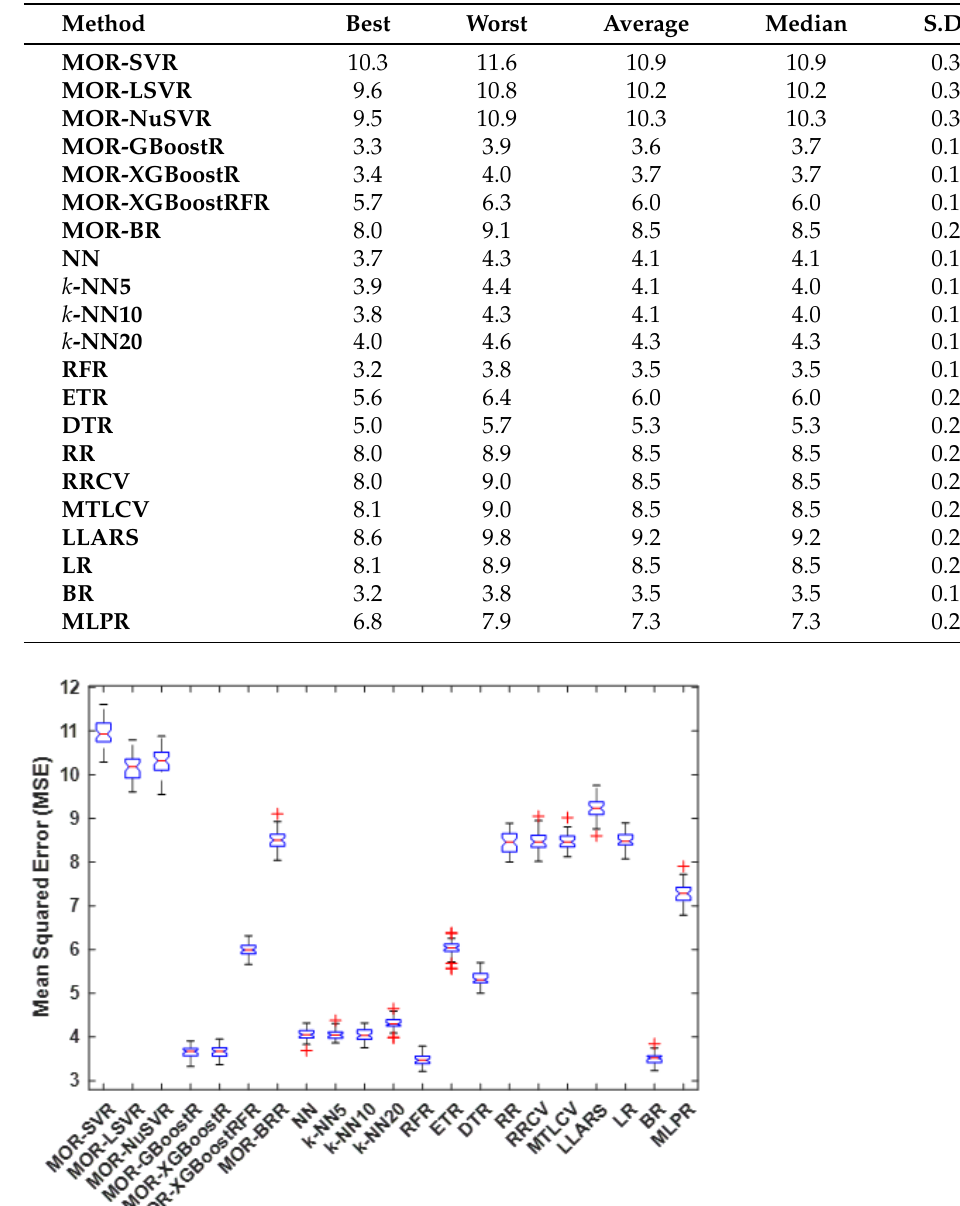
Table 11. Mean squared error (MSE) for all methods over 50 statistical runs (the second stage).